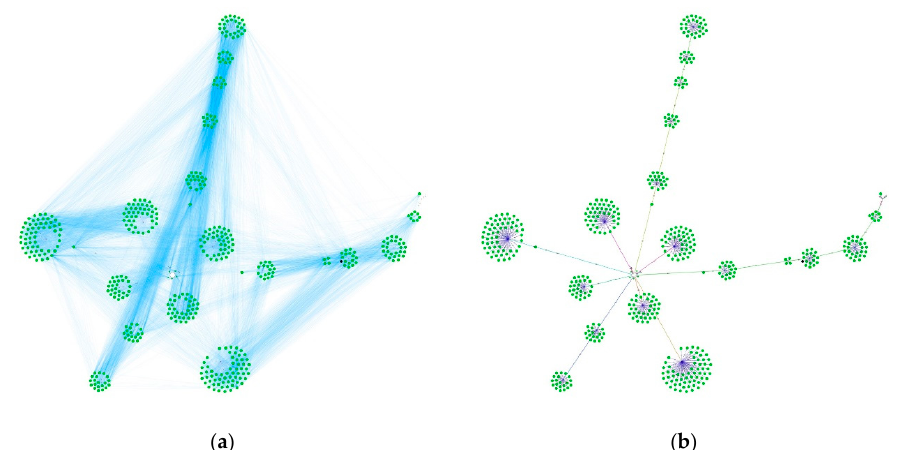
Figure 6. Links ( a ) and routes ( b ) over a same G3-PLC network topology.